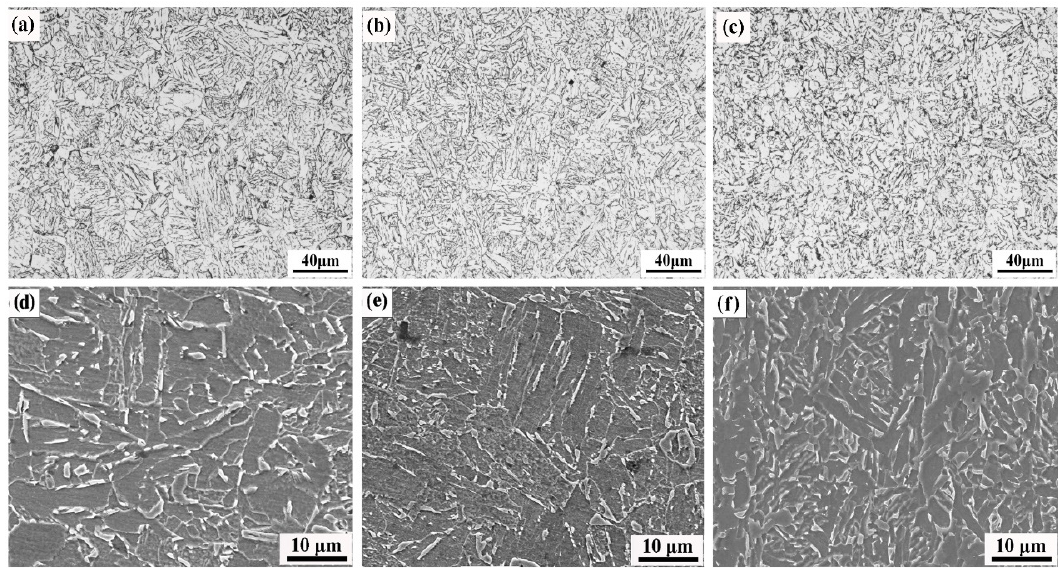
Figure 4. The microstructure of different cooling rate at the compression ratio of 0.5. ( a , d ) 10 °C/s, ( b , e ) 20 °C/s, ( c , f ) 30 °C/s.